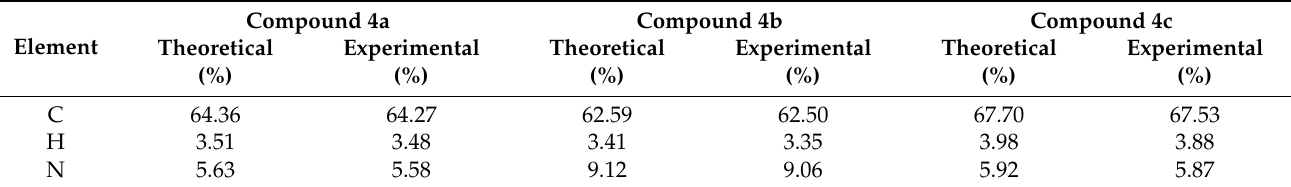
Table 1. CHN elemental analysis for compounds 4a – c